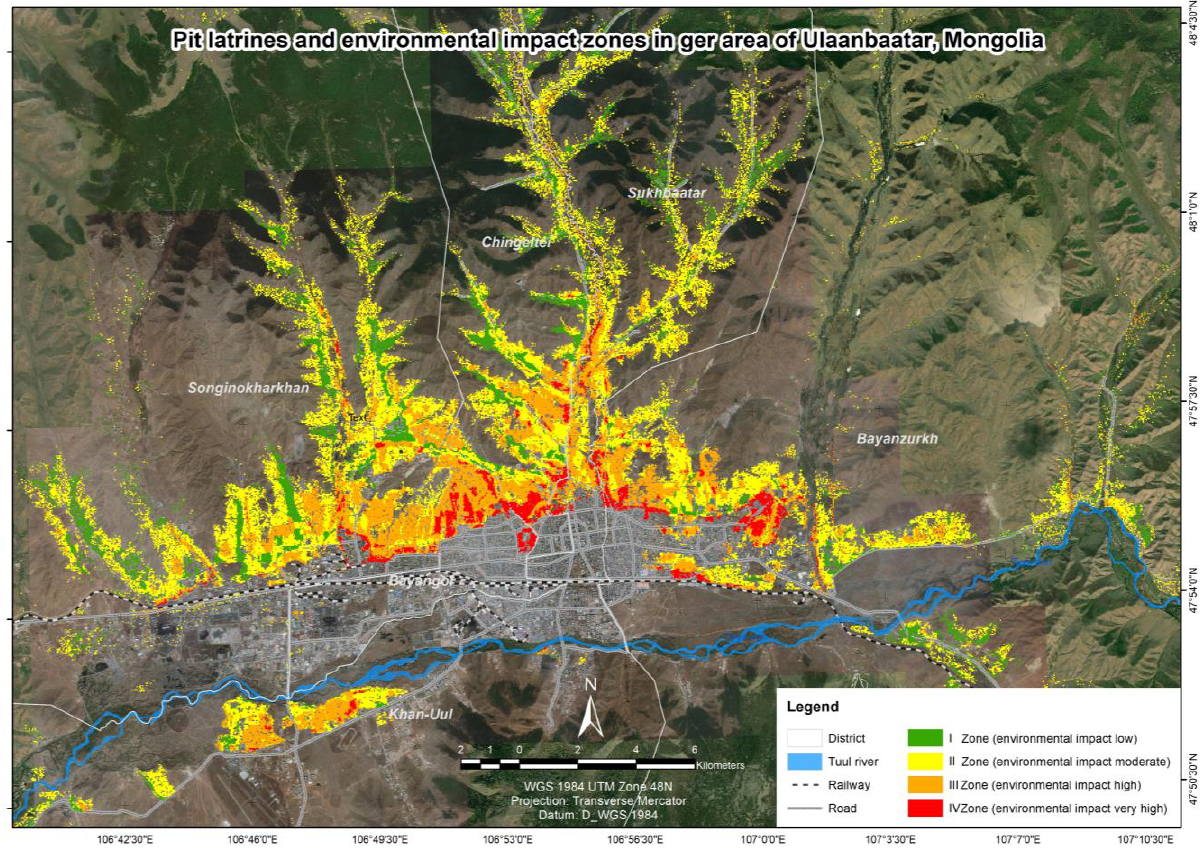
Figure 5. Pit latrines and environmental impact zones in ger area of Ulaanbaatar,